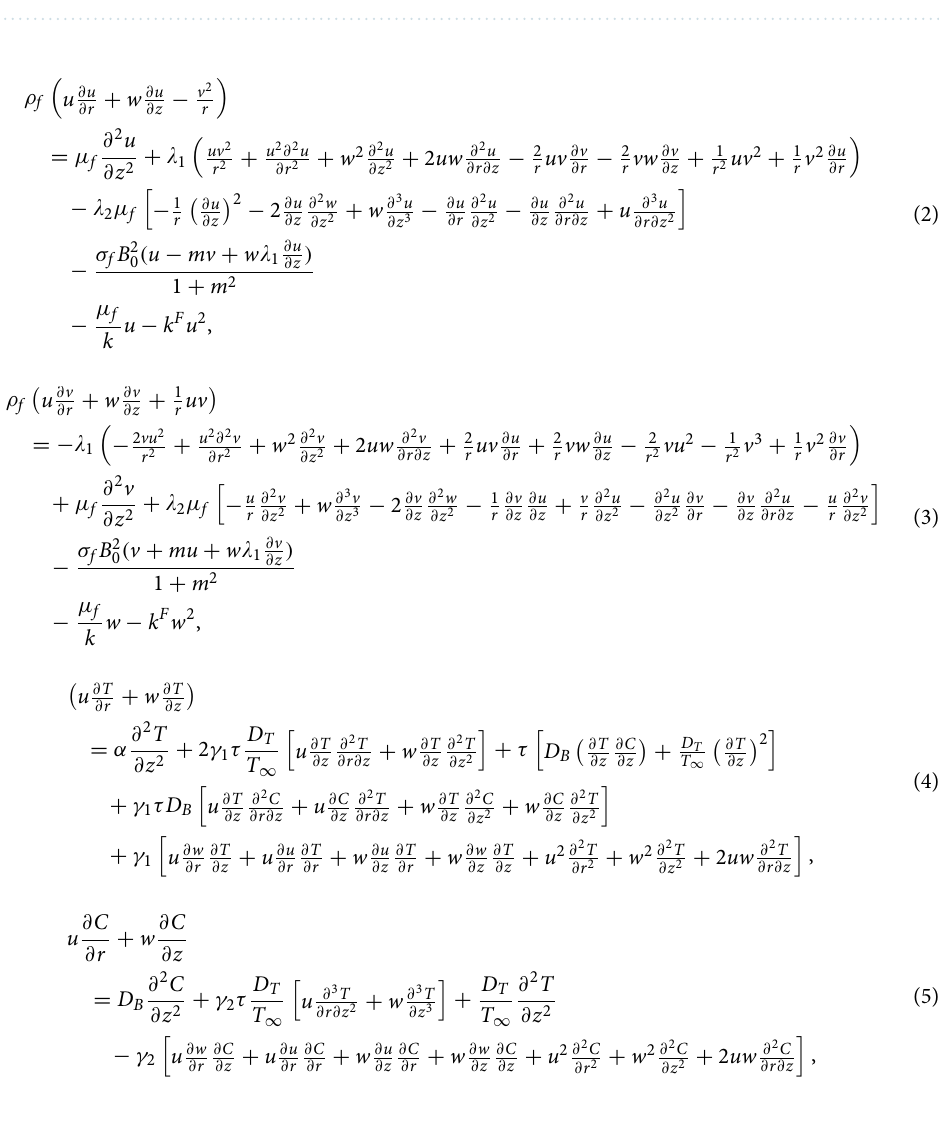
Figure 1. A plot presents the